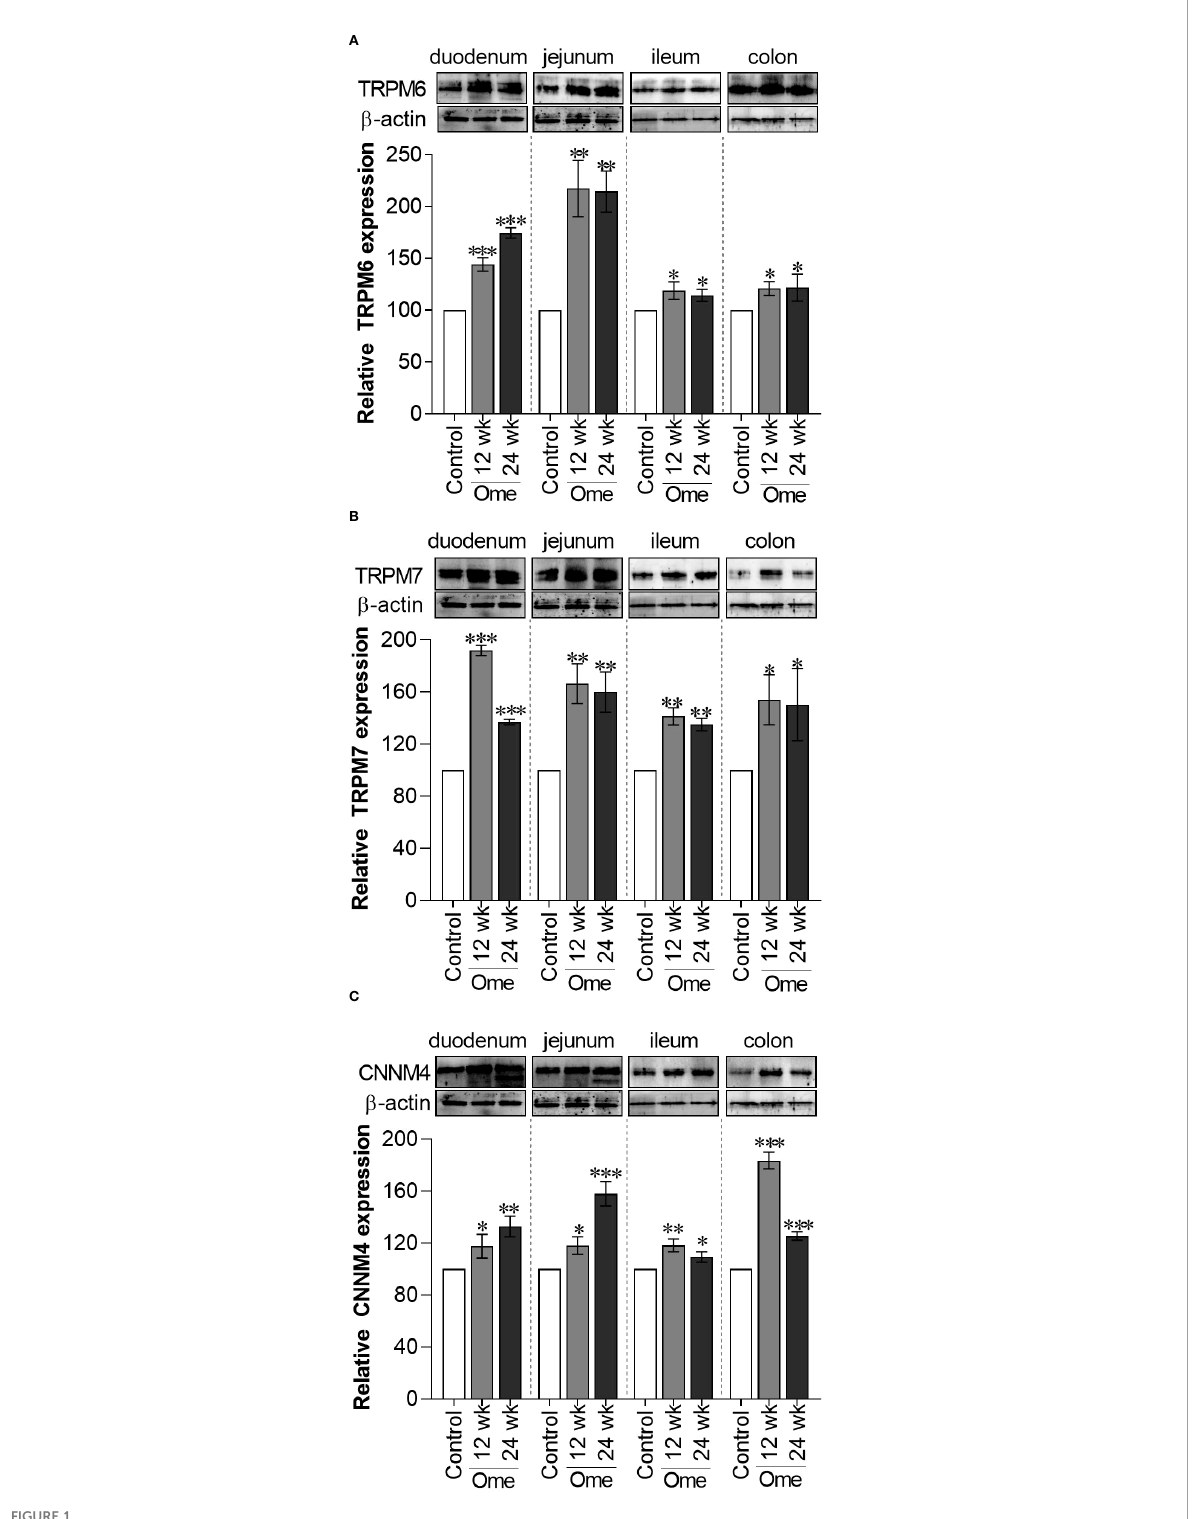
FIGURE 1 Total TRPM6 (A) , TRPM7 (B) , and CNNM4 (C) expression in duodenum, jejunum, ileum, and colon of control or omeprazole treated rats. ome; omeprazole. * P < 0.05, ** P < 0.01, *** P < 0.001. ( n =